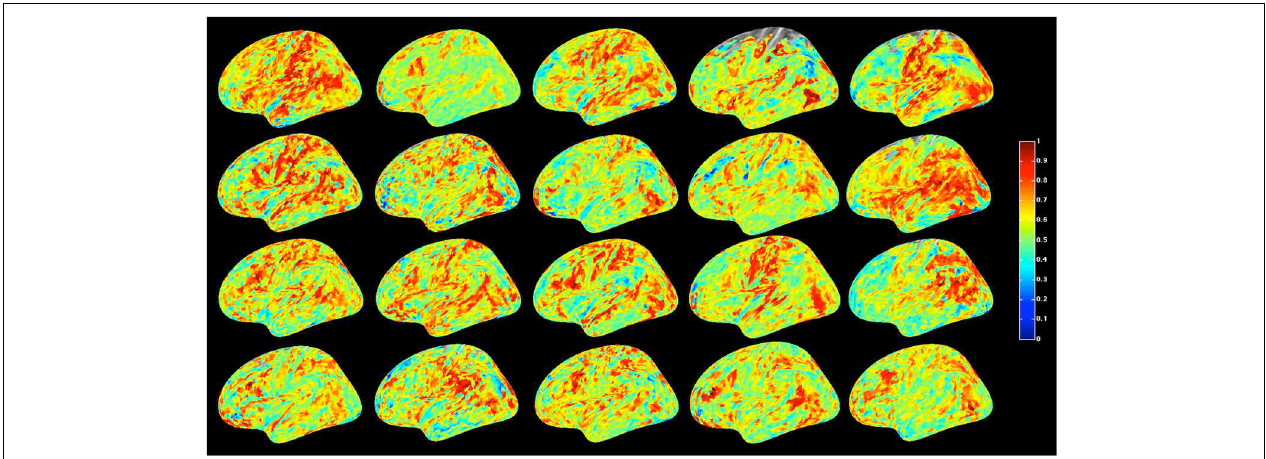
FIGURE 1 | Global resting-state cortical correlation maps in 20 subjects. Pseudo-color indicates the average cross-correlation of each voxel with the rest of the